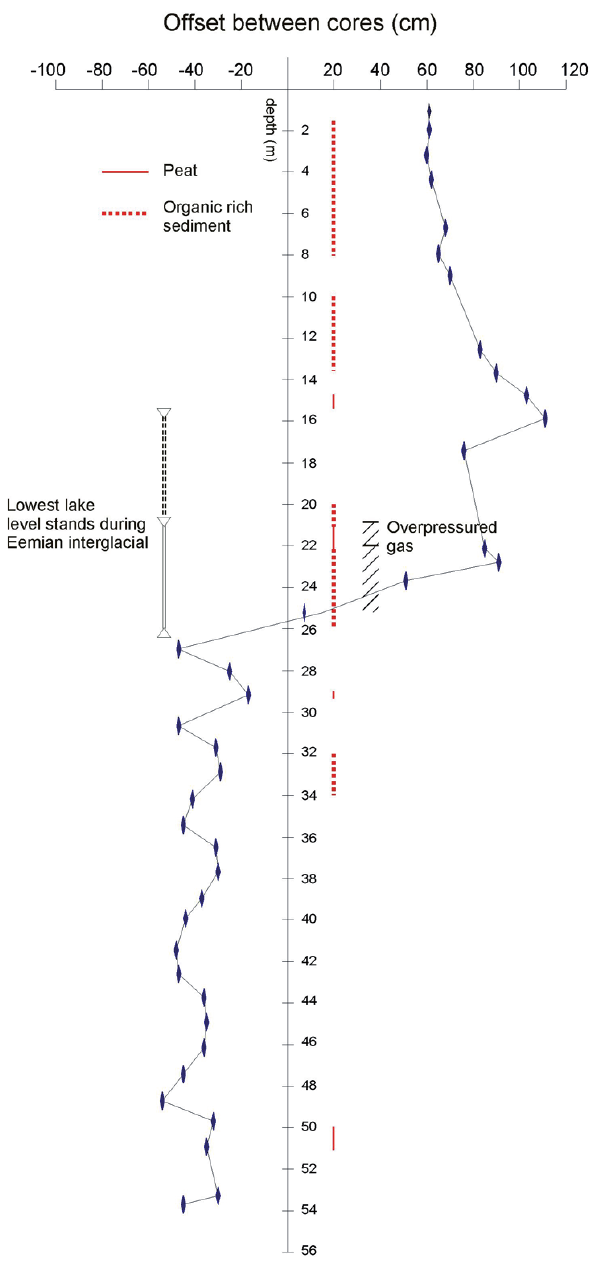
Fig. 3. Graph of down-core changes in the offset between cores F´uquene-9 and F´uquene-10. Blue ellipses represent the tie points as indicated in Table 2 in the Supplement. Gaps between vertical red lines represent mineral-rich